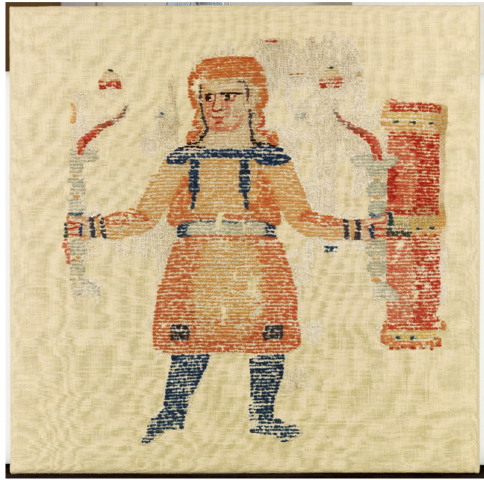
Figure 11. Hanging , 420–570 CE. Byzantine; Egypt. Loop weaving in wool and linen; 75 × 69 cm (29 1/2 × 27 1/8 in.). Musée du Louvre, E 10530. Photo: Thierry Ollivier. © RMN-Grand Palais/Art Resource, NY.